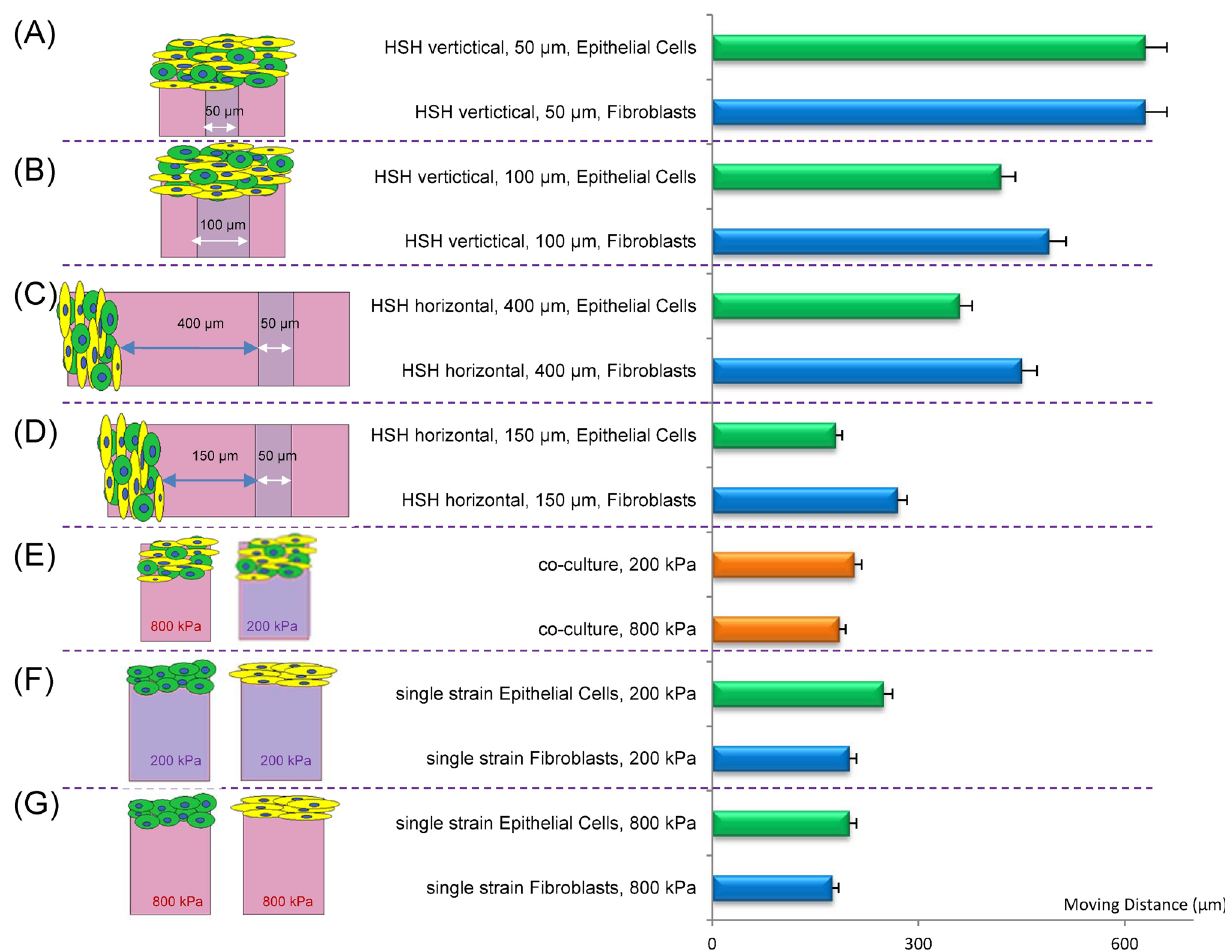
Figure 9. A summary of the cell motility results. The leading cell movement from 0 to 24 h for ( A ) co-cultured cells on the HSH vertical with a 50 μm wide stripe, ( B ) co-cultured cells on the HSH vertical set up with a 100 μm wide stripe, ( C ) co-cultured cells on the HSH horizontal at a distance of 400 μm from the stripe, ( D ) co-cultured cells on the HSH horizontal at a distance of 150 μm from the stripe, ( E ) co-cultured cells on a uniform substrate with stiffnesses of either 800 kPa or 200 kPa, ( F ) just A549 epithelial cells or WI-38 fibroblasts on uniform substrate with a stiffness of 200 kPa, and ( G ) just A549 epithelial cells or WI-38 fibroblasts on uniform substrate with a stiffness of 800 kPa. The single cell type results were divided by 2 from the 48 h leading cell experiments, to approximate a comparison to the 24-h time on the polymer composite system and their cell type. Both fibroblasts and the epithelial cells were observed to have increased motility when they were on our polymer composite system compared to the cells attached to the uniform substrate. The fibroblasts were observed to have a higher cell density on the soft substrate than the epithelial cells through our approach. This approach could be useful in a variety of areas including cell-substrate interactions, mechanobiology, cell motility, and cell separation.